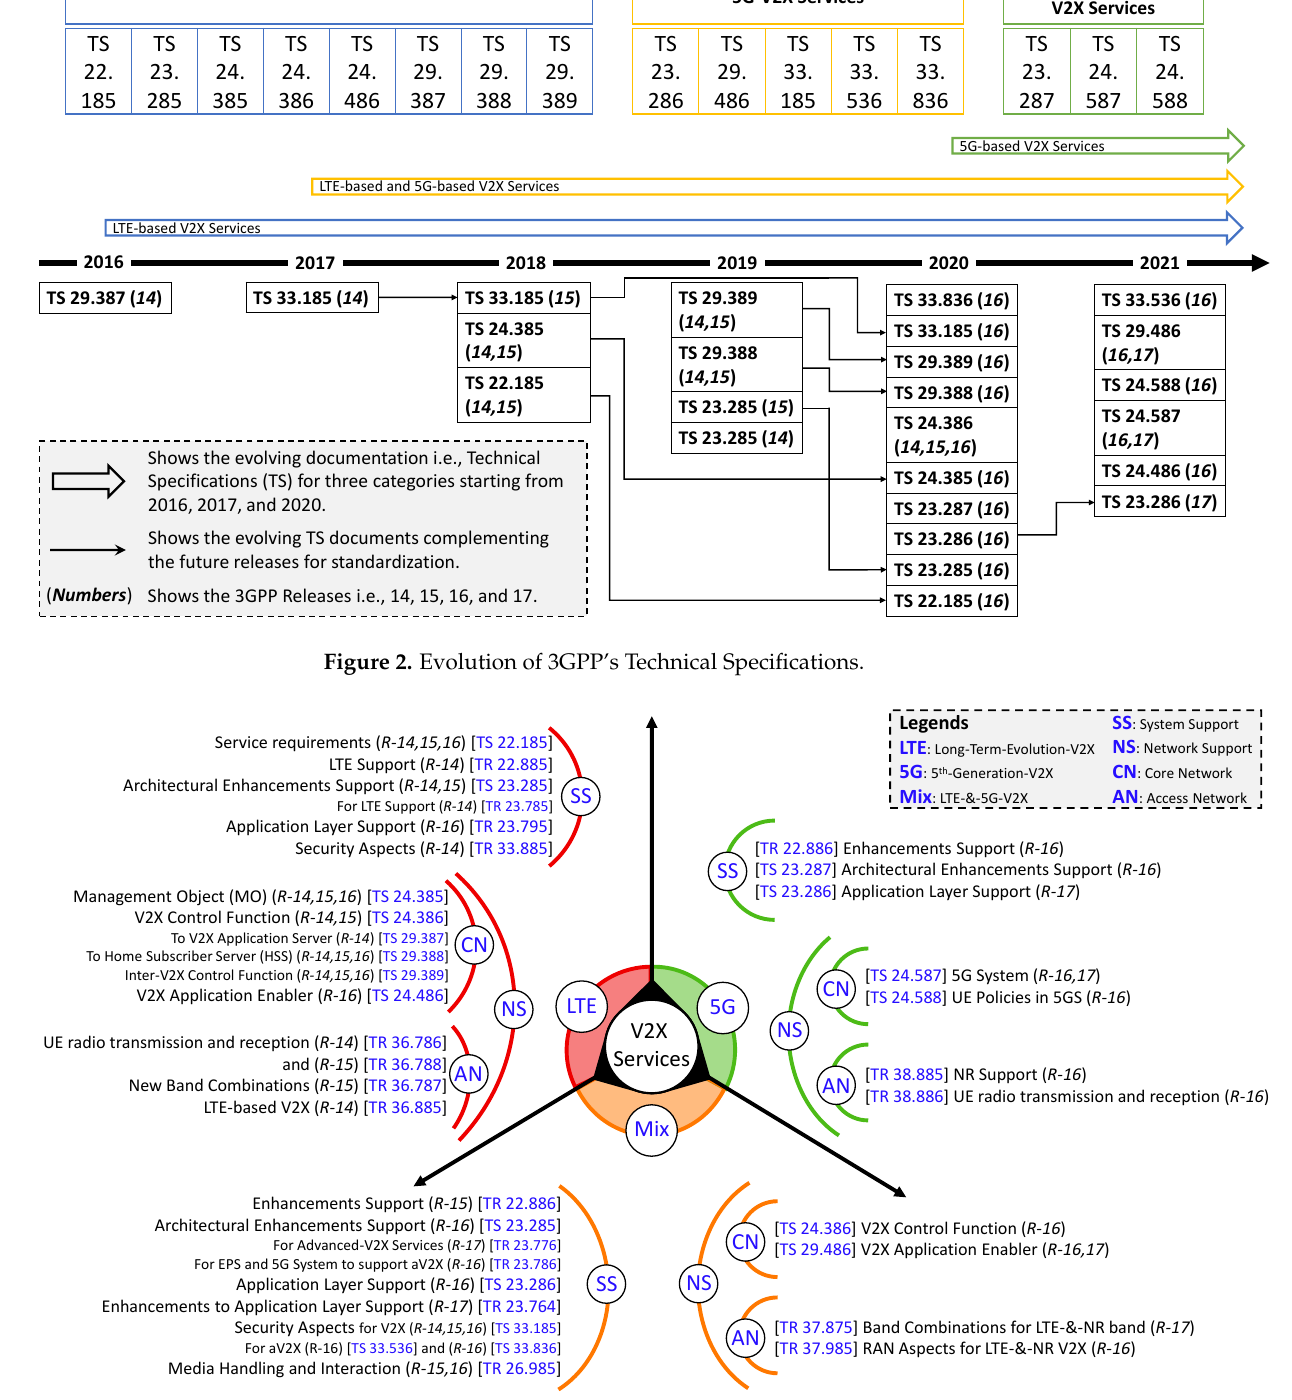
Figure 3. System and Network Support for V2X